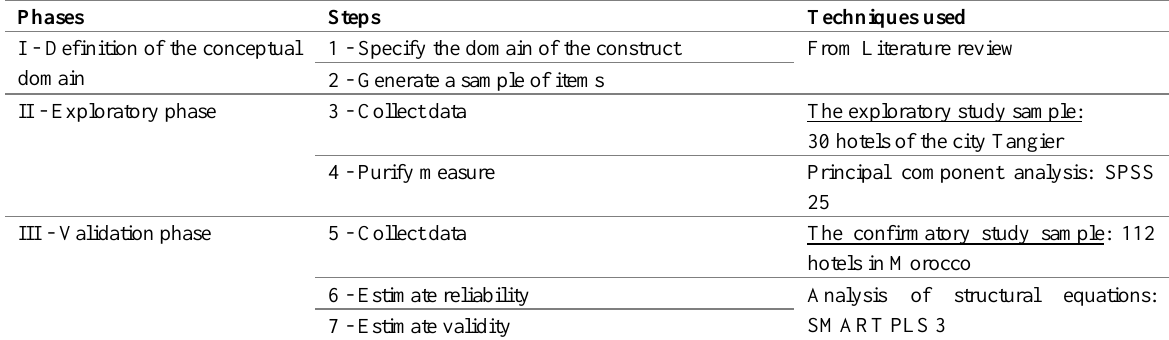
Table 1: Research methodology according to Churchill